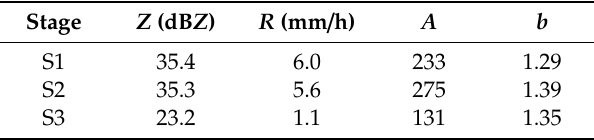
Table 5. Mean Z , mean R and Z – R relationship ( Z = AR b ) for the three raining stages of the typhoon event (2005-11).